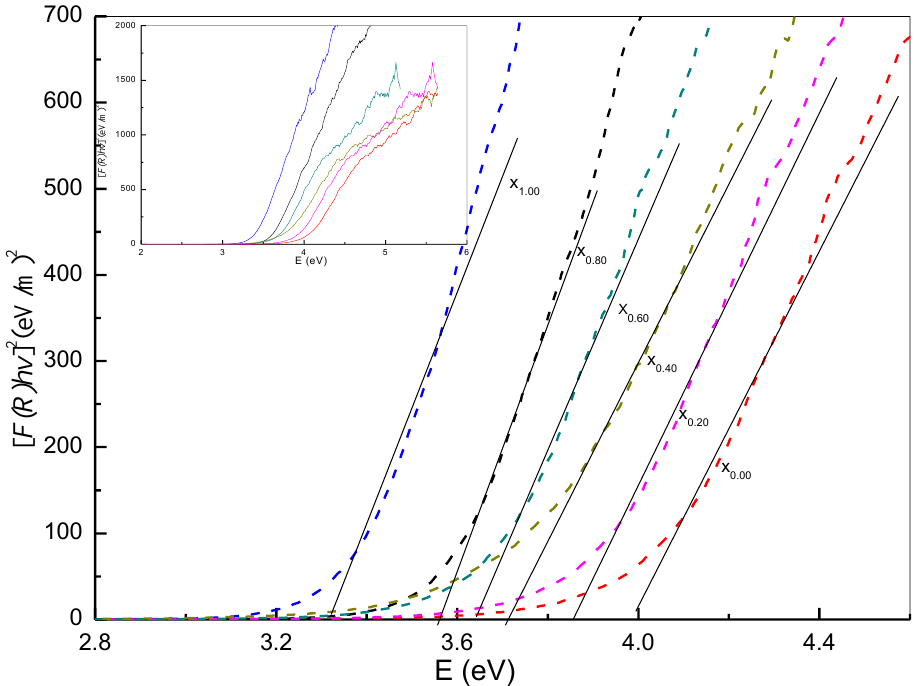
Figure 8. The energy bandgap of (x 0.00 ) Ce 0.00 Sn 1.00 O 2 , (x 0.20 ) Ce 0.20 Sn 0.80 O 2 , (x 0.40 ) Ce 0.40 Sn 0.60 O 2 , (x 0.06 ) Ce 0.60 Sn 0.40 O 2 , (x 0.08 ) Ce 0.80 Sn 0.20 O 2 , and (x 1.00 ) Ce 1.00 Sn 0.00 O 2 ) nanoparticles calcined at 650 °C.